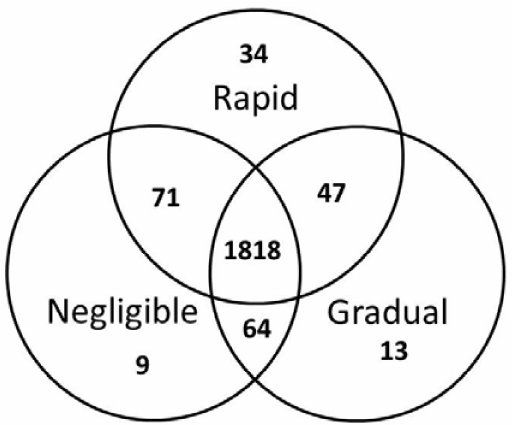
Figure 2. Venn diagram showing the overlapped and unique blood plasma metabolites ions detected by direct mass spectrometry profiling at positive mode in the samples of negligible ( Esox Lucius and Acipenser ruthenus ), gradual ( Sander lucioperca and Perca fluviatilis ) and rapid ( Oncorhynchus keta and Oncorhynchus gorbuscha ) ageing